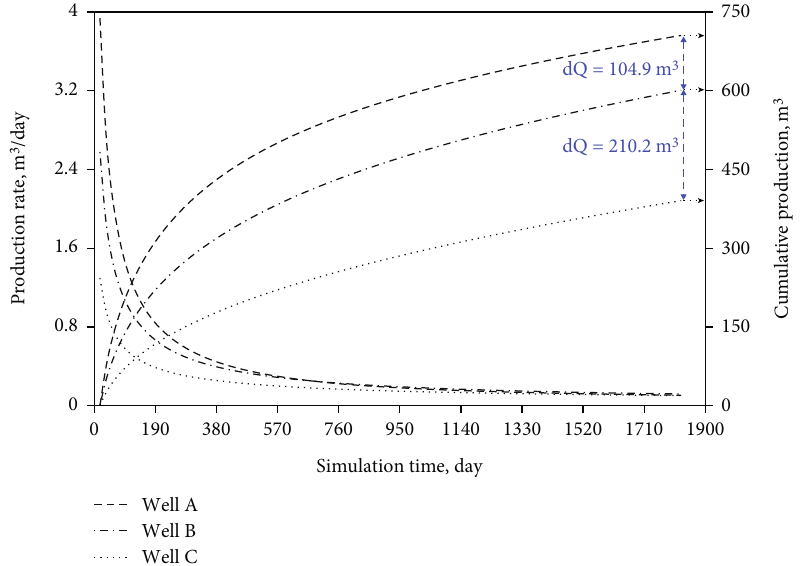
Figure 15: Comparison of well performances of the three long horizontal wells.